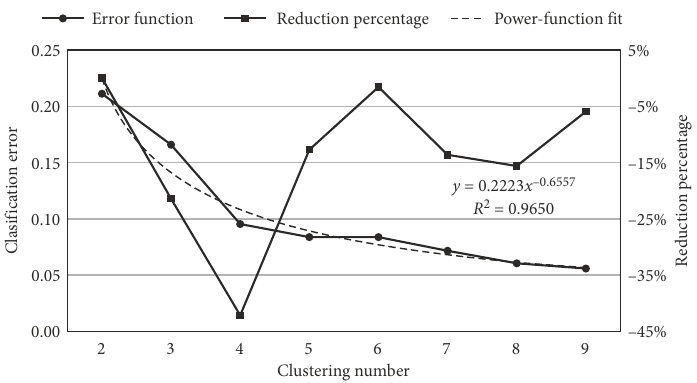
Figure 2. Dynamic classification results corresponding to different classification number